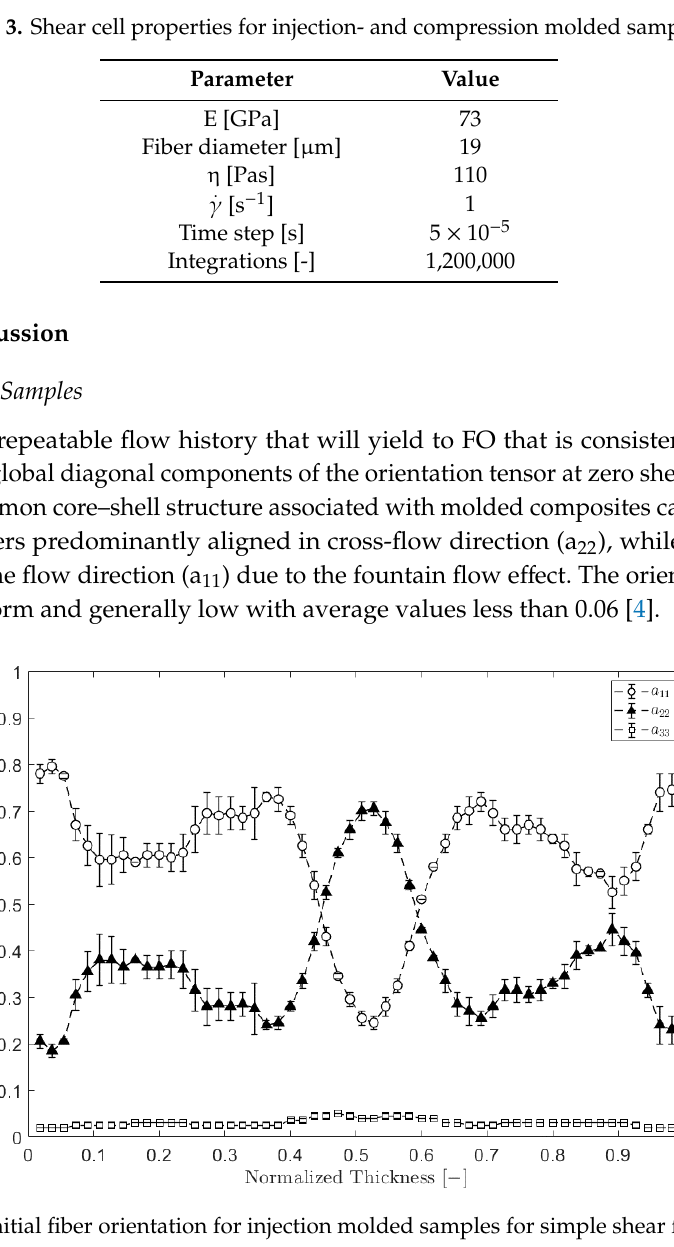
Figure 8. Initial fiber orientation for injection molded samples for simple shear flow tests.